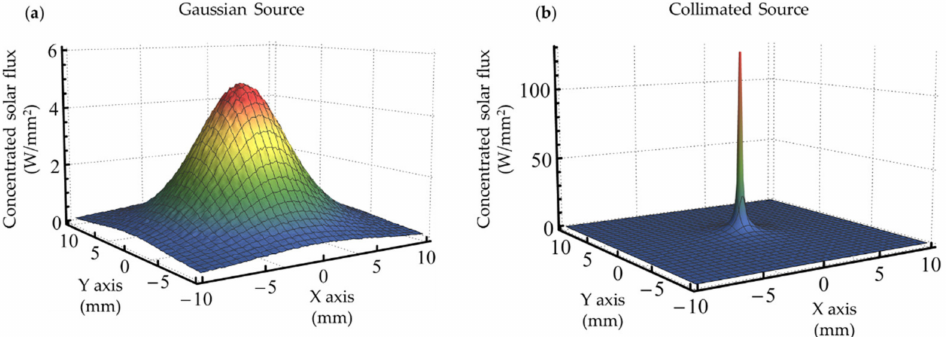
Figure 10. The focal image formed by ESFL modeled at 1000 W/mm 2 irradiance with the ( a ) Gaussian source and ( b ) collimated